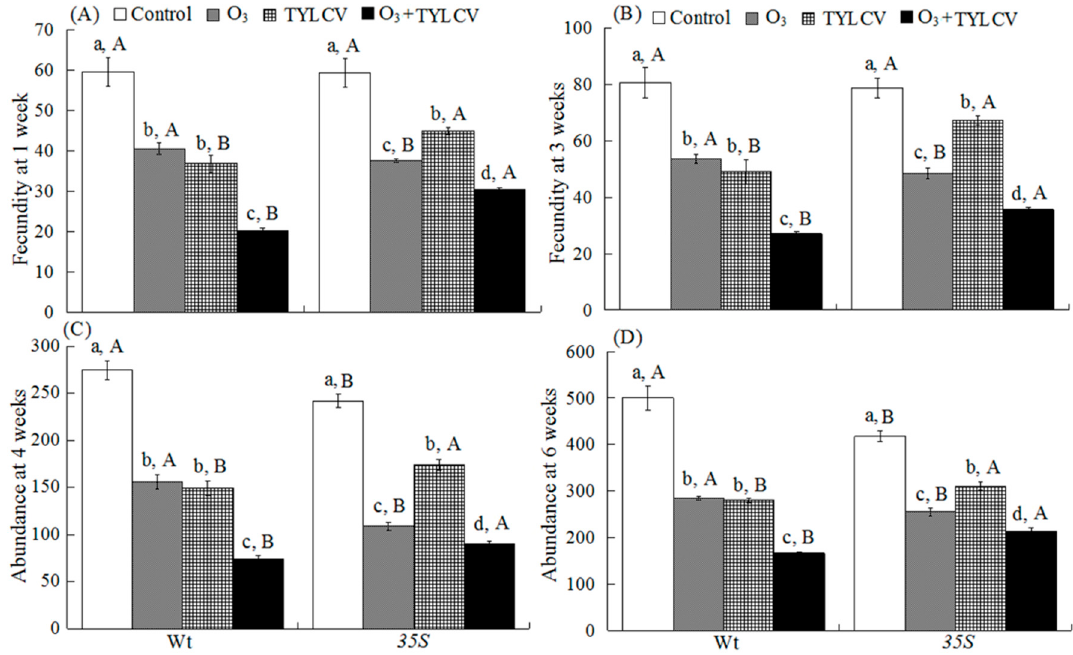
Figure 5. B. tabaci fecundity ( A ) at one week; and ( B ) at three weeks; and B. tabaci numbers per plant ( C ) at four weeks; and ( D ) at six weeks on two tomato genotypes (Wt and 35S ) grown under ambient and elevated O 3 with and without TYLCV infection. Treatments are explained in Figure 1. Each value represents the average (±SE) of 24 replicates. Different lowercase letters within a row indicate significant differences among the four treatments in a specific tomato cultivar, and different uppercase letters indicate significant differences between the two tomato genotypes within the same treatment (Tukey’s test: p < 0.05). “Weeks” refer to the start of the oviposition period of the single